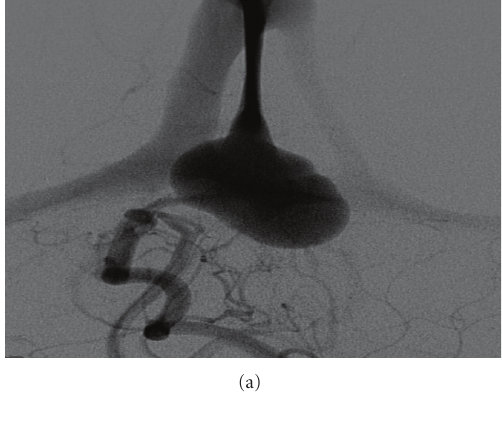
Figure 3: Angio-MRI (TOF): arterialization of the Vein of Galen and consecutive dilatation (arrow).